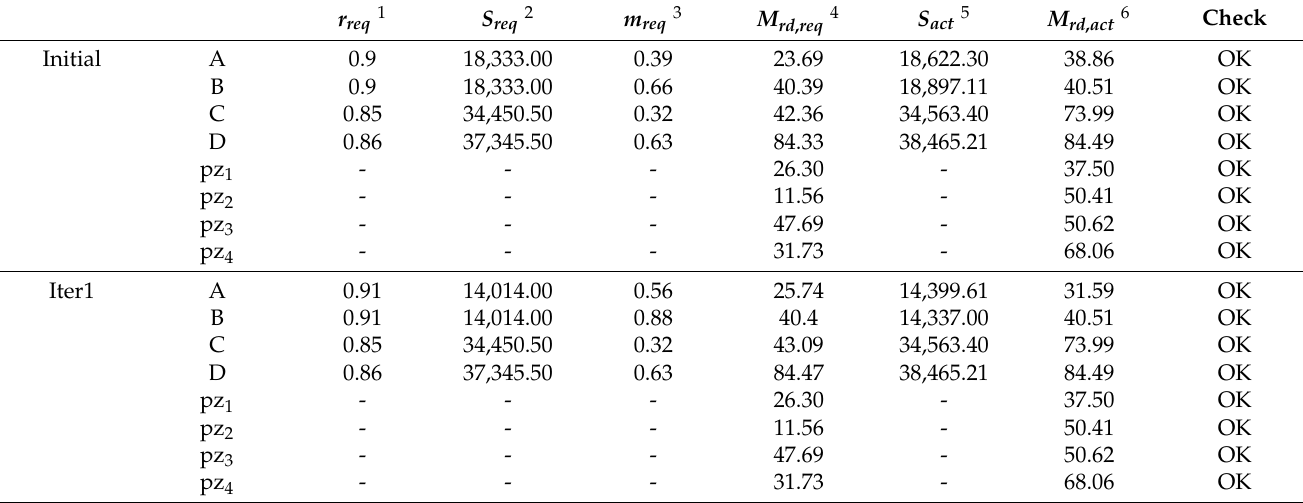
Table 5. Frame A: Required joint properties in each iteration.